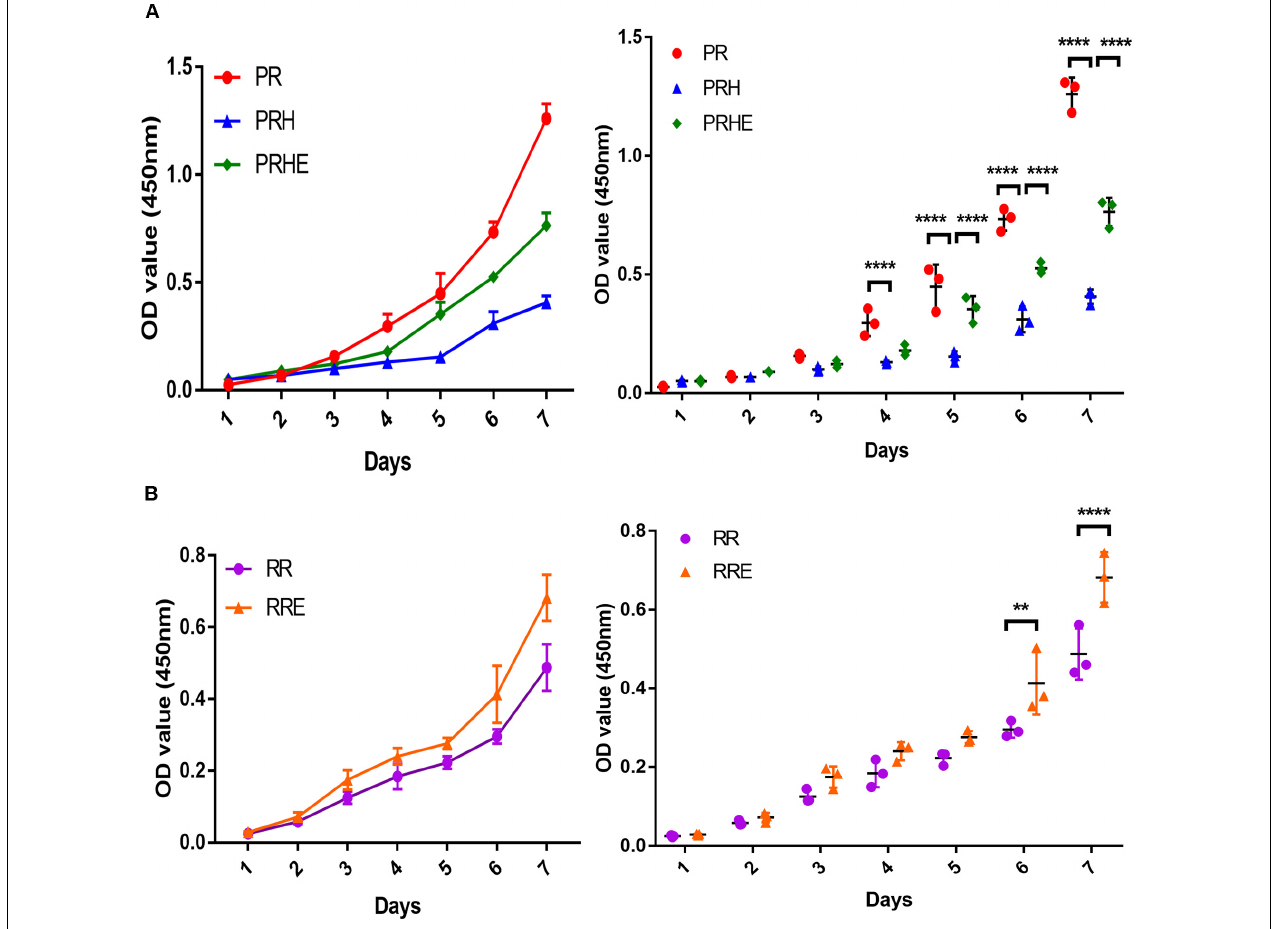
FIGURE 3 | The cocultured embryonic stem cells (ESCs) increased the proliferative capacity of premature and replicative senescent RPE cells. (A) Proliferation of the PR, PRH, and PRHE groups, as assessed by a CCK-8 proliferation assay ( n = 3 biological repeats). (B) Proliferation of the RR and RRE groups, as assessed by a CCK-8 proliferation assay ( n = 3 biological repeats). Data are presented as the mean ± SD. ∗∗ P < 0.01; ∗∗∗∗ P < 0.0001. PR: RPE cells of the control group from passages 4 to 6; PRH: RPE cells from passages 4 to 6 treated with 400 µ M H 2 O 2 ; PRHE: RPE cells from passages 4 to 6 treated with 400 µ M H 2 O 2 and then cocultured with ESCs. RR: RPE cells of the control group from passages 8 to 10; RRE: RPE cells from passages 8 to 10 cocultured with